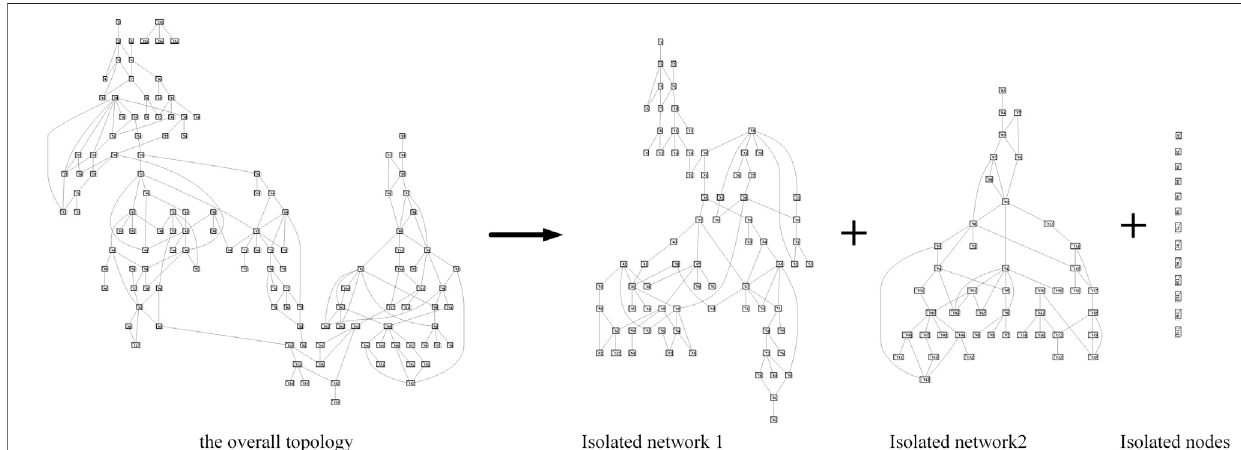
FIGURE 11 | Network structure after topology identi fi cation.